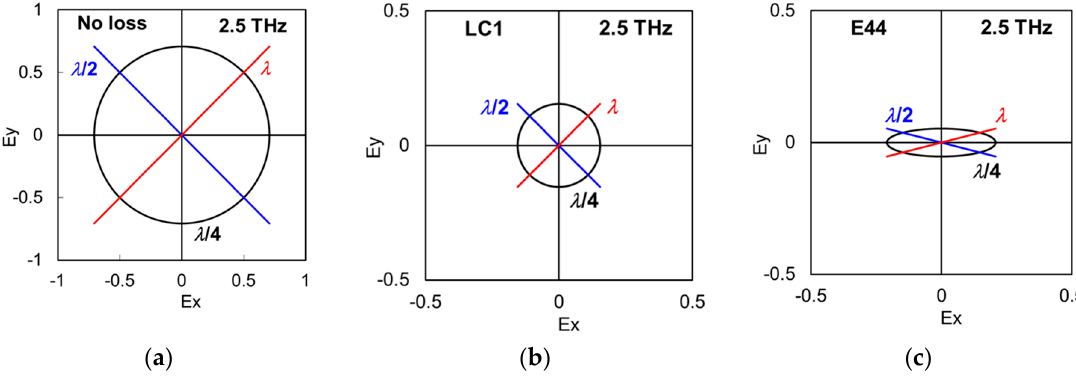
Figure 7. Simulation results of the polarization conditions of a transmitted terahertz wave. We set the absorption values for ( a ) zero (no loss), ( b ) LC1, and ( c ) E44. Retardation of the LC device was λ , λ /2, and λ /4.